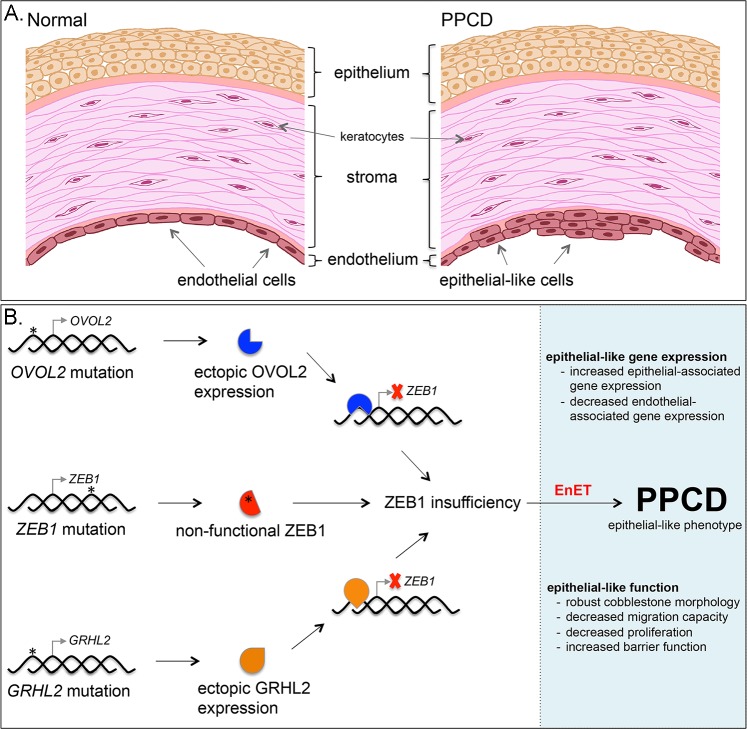
Model for the role of ZEB1 in PPCD characterized by EnET.(A) Illustration of the cornea depicts the three main cellular layers, the anterior stratified organization of the epithelial cells comprising the epithelium, the collagen-rich stroma containing dispersed keratocytes, and the posterior corneal endothelium, which is characterized by a monolayer of corneal endothelial cells. In PPCD, the corneal endothelium is characterized by foci of epithelial-like cells present in a stratified organization, characteristic of the corneal epithelium. (B) Schematic of the genotype-to-phenotype model of PPCD. Truncating mutations (*) in ZEB1 were the first mutations associated with PPCD. The non-functional mutant protein (red symbol with asterisk) leads to ZEB1 insufficiency and endothelial to epithelial transition (EnET), which forms the basis for the characteristic clinical and histopathologic features of PPCD. Mutations in the promoter region of OVOL2 or GRHL2 release intrinsic repression of these genes and lead to ectopic production of their respective transcription factors in the corneal endothelium. OVOL2 (blue symbol) and GRHL2 (orange symbol) are known to directly repress ZEB1 gene transcription (red X) by binding to the ZEB1 promoter. Consequently, ZEB1 transcription is reduced, leading to ZEB1 insufficiency and EnET.